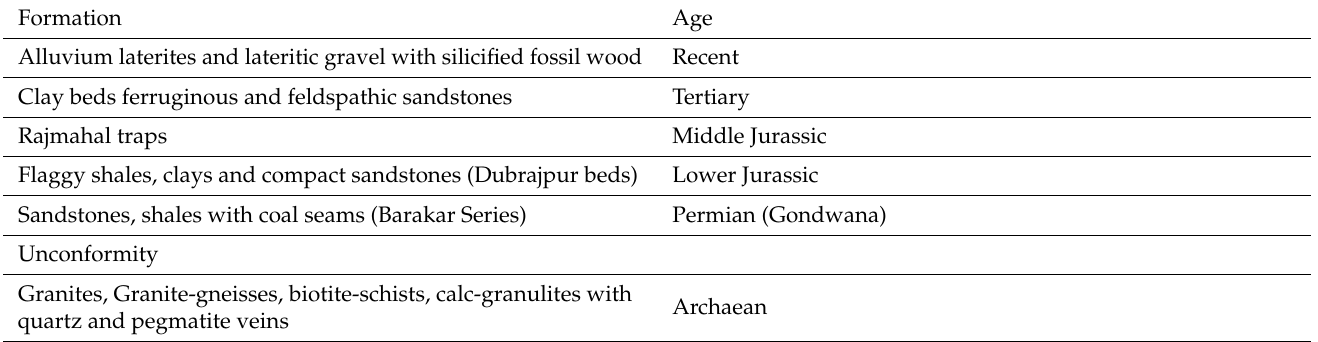
Table 7. Stratigraphic sequence in the Birbhum area.